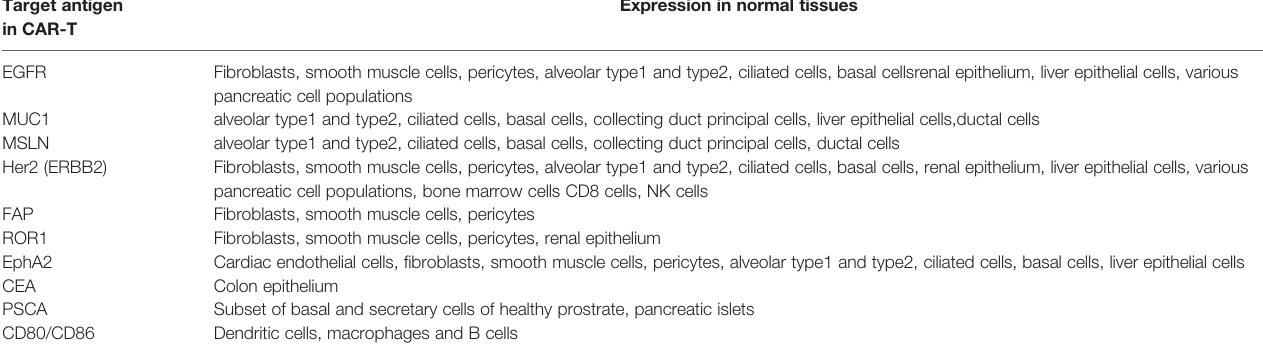
Expression in normal